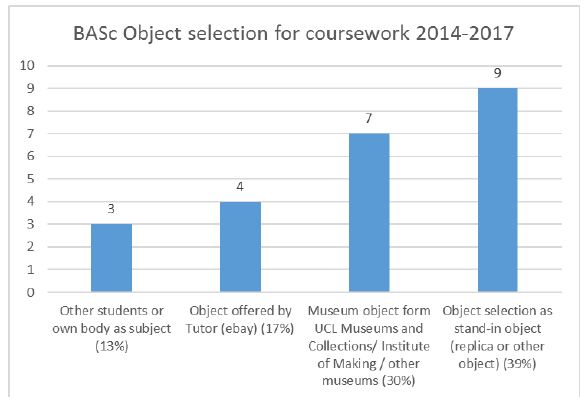
Figure 3. Object selection for 3D coursework in BASc2082.